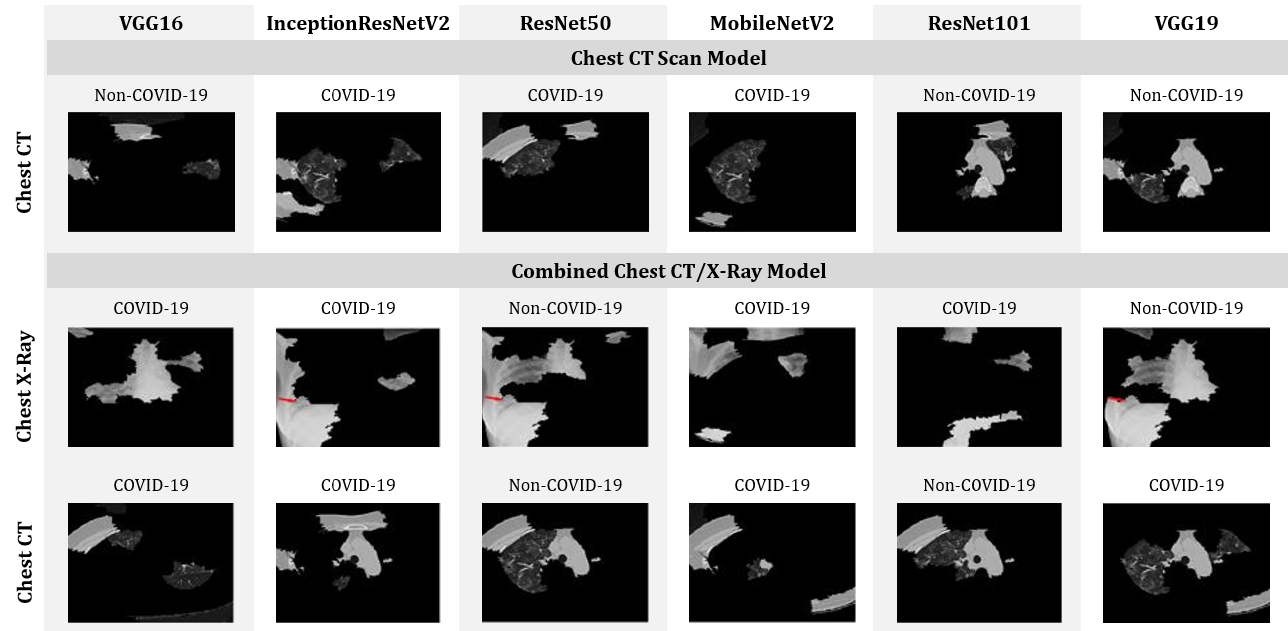
Figure 9. Top four features that enabled the identification of COVID-19 patients from CT-scan-only and mixed datasets.